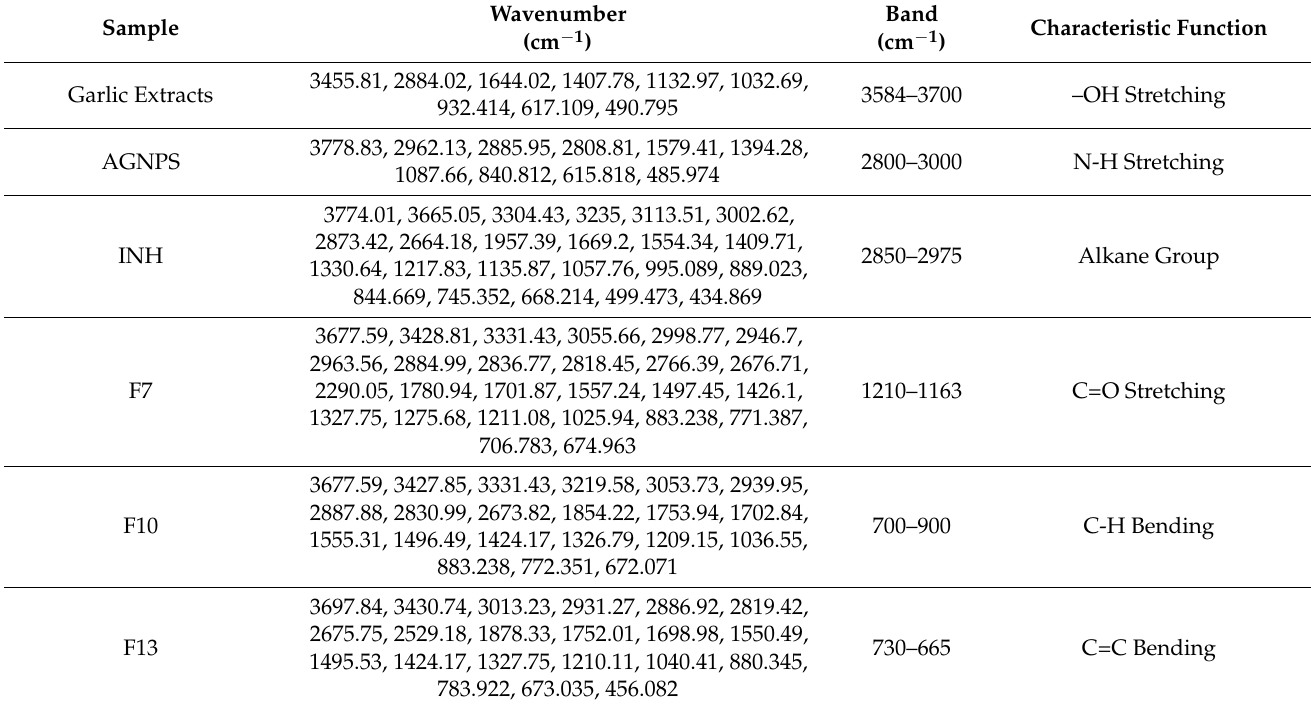
Table 1. The FTIR spectrum wavenumbers and its concern bands of